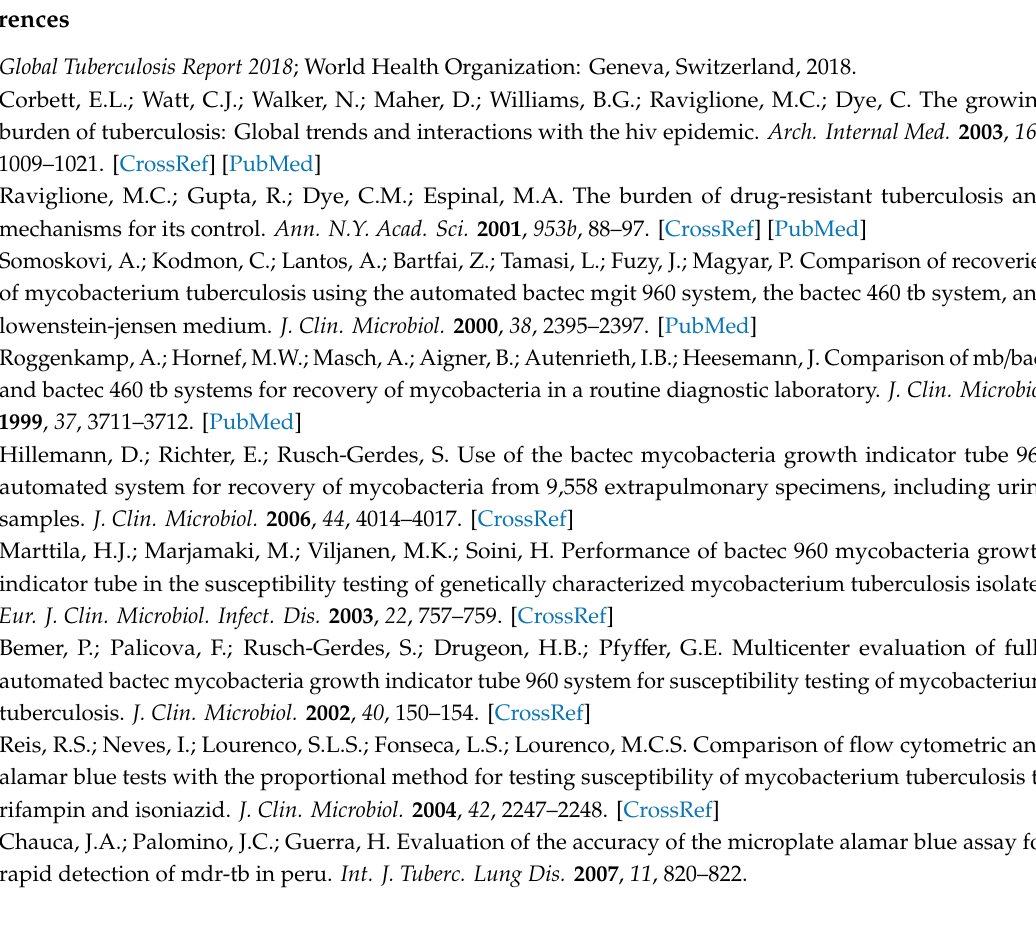
Figure S1: Droplet based microfluidic chip, Figure S2: Determination for the limit of detection for PZA and POA solved in high purity water, Table S1: band assignment for PZA and POA according to the cited literature, Measurement